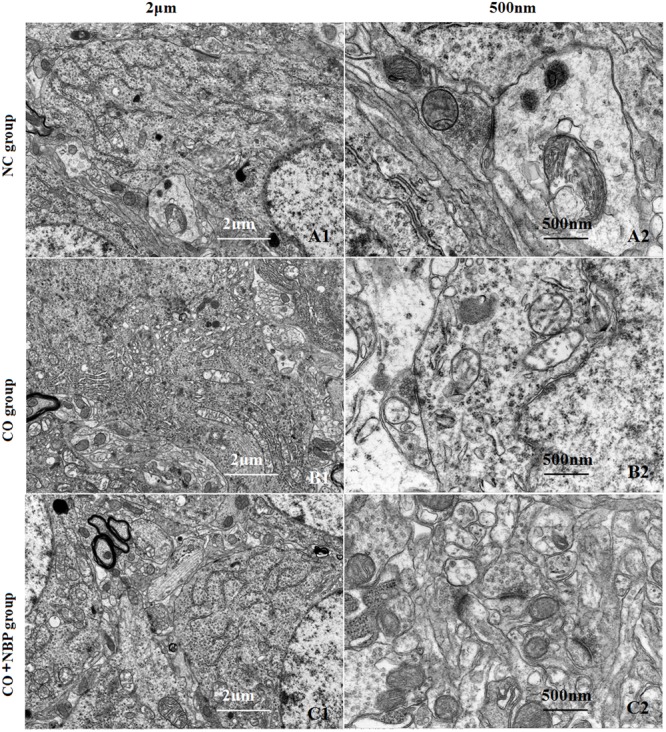
Transmission electron microscopy (TEM) photographs of pathological changes in hippocampus in different groups. The exterior contour of neurons in NC group was clear, with big and round nucleus and uniform chromatin on days 3 (A1). The double nucleus membrane was clear and complete. Organelles were rich and scattered in cytoplasm with structural integrity (A2). Hippocampal neurons were swelled, chromatin in the nucleus was condensed and marginalized, and cristae and membrane were broken. Meanwhile, mitochondria appeared to be vacuolization, and partial cell organelle dissoluted and disappeared in CO poisoning group on days 3 (B1,B2). By contrast, the double-deckered nuclear membrane of neuron was clear, and mitochondria and other organelles were normal or only slightly damaged in CO+NBP group on days 3 (C1,C2).